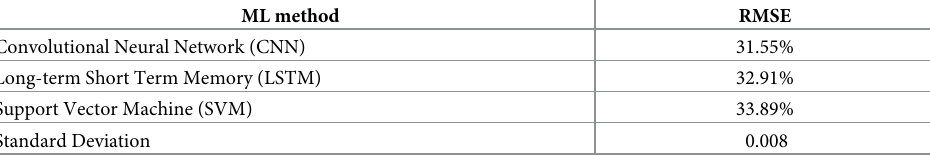
Table 3. Root Mean Square Error (RMSE) averages for predictions using real-world